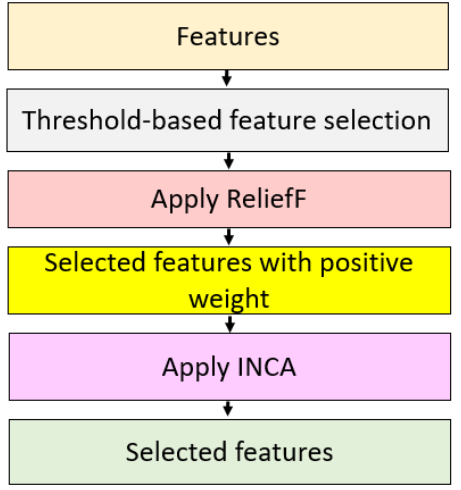
Figure 4. Block diagram of the TSRFINCA model.